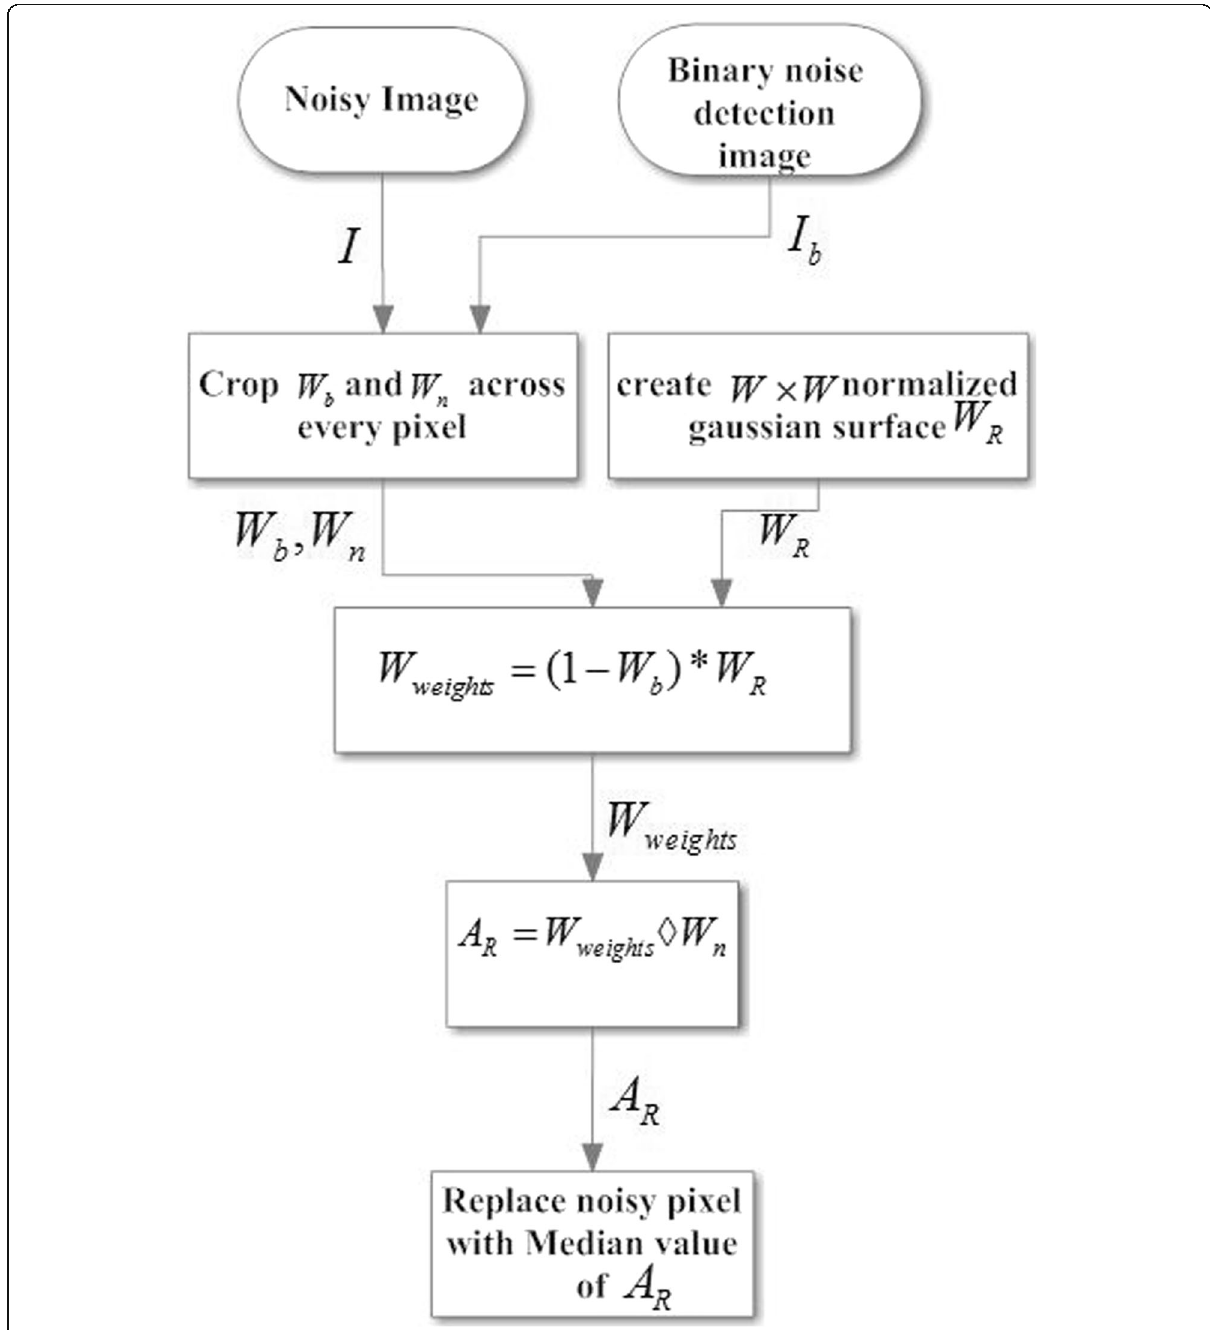
Fig. 4 Flowchart of the proposed